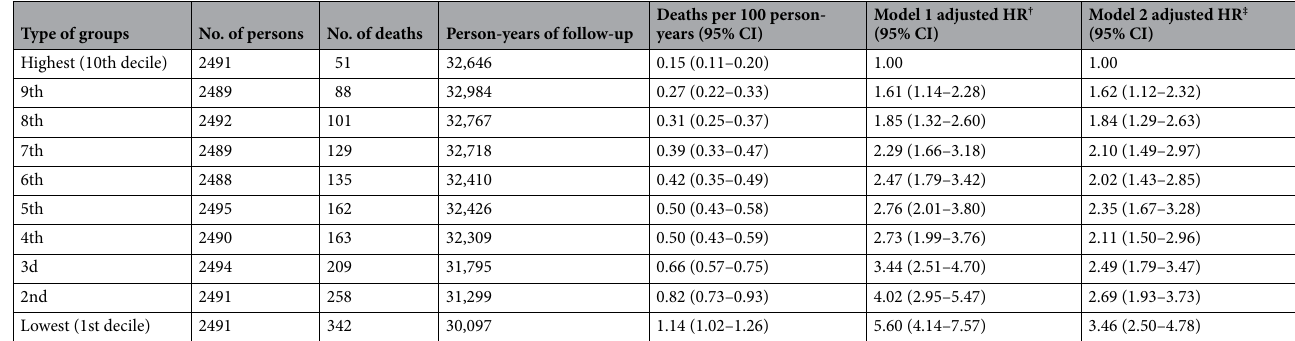
Table 3. Association between FEV1/height 3 deciles and CVD mortality. FEV1 forced expiratory volume in 1 s, CI confidence interval, HR hazard ratio. † Adjusted for age, sex and country. ‡ Adjusted for occupation and education; alcohol consumption, smoking status, level of physical activity and body mass index; history of hypertension, ischemic heart disease, myocardial infarction,